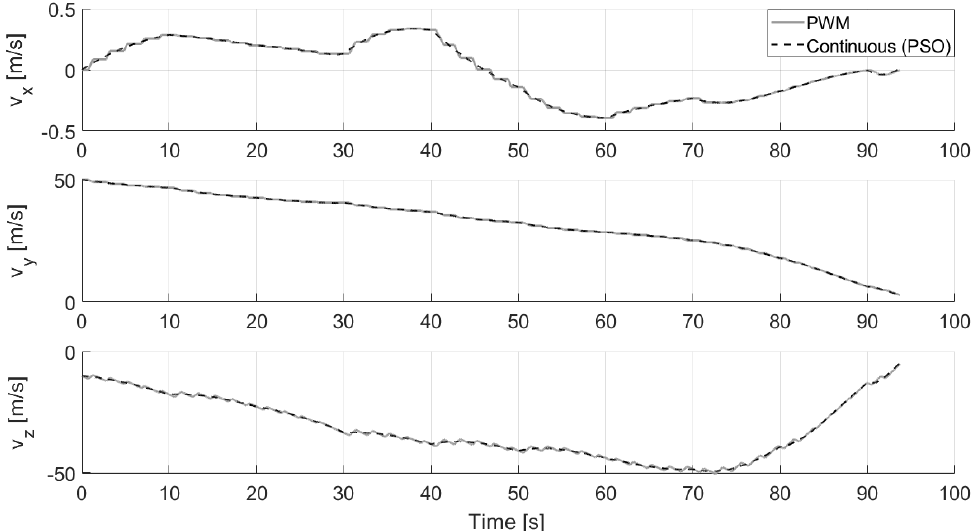
Figure 15. Time-history of velocity with 10 successive optimizations.